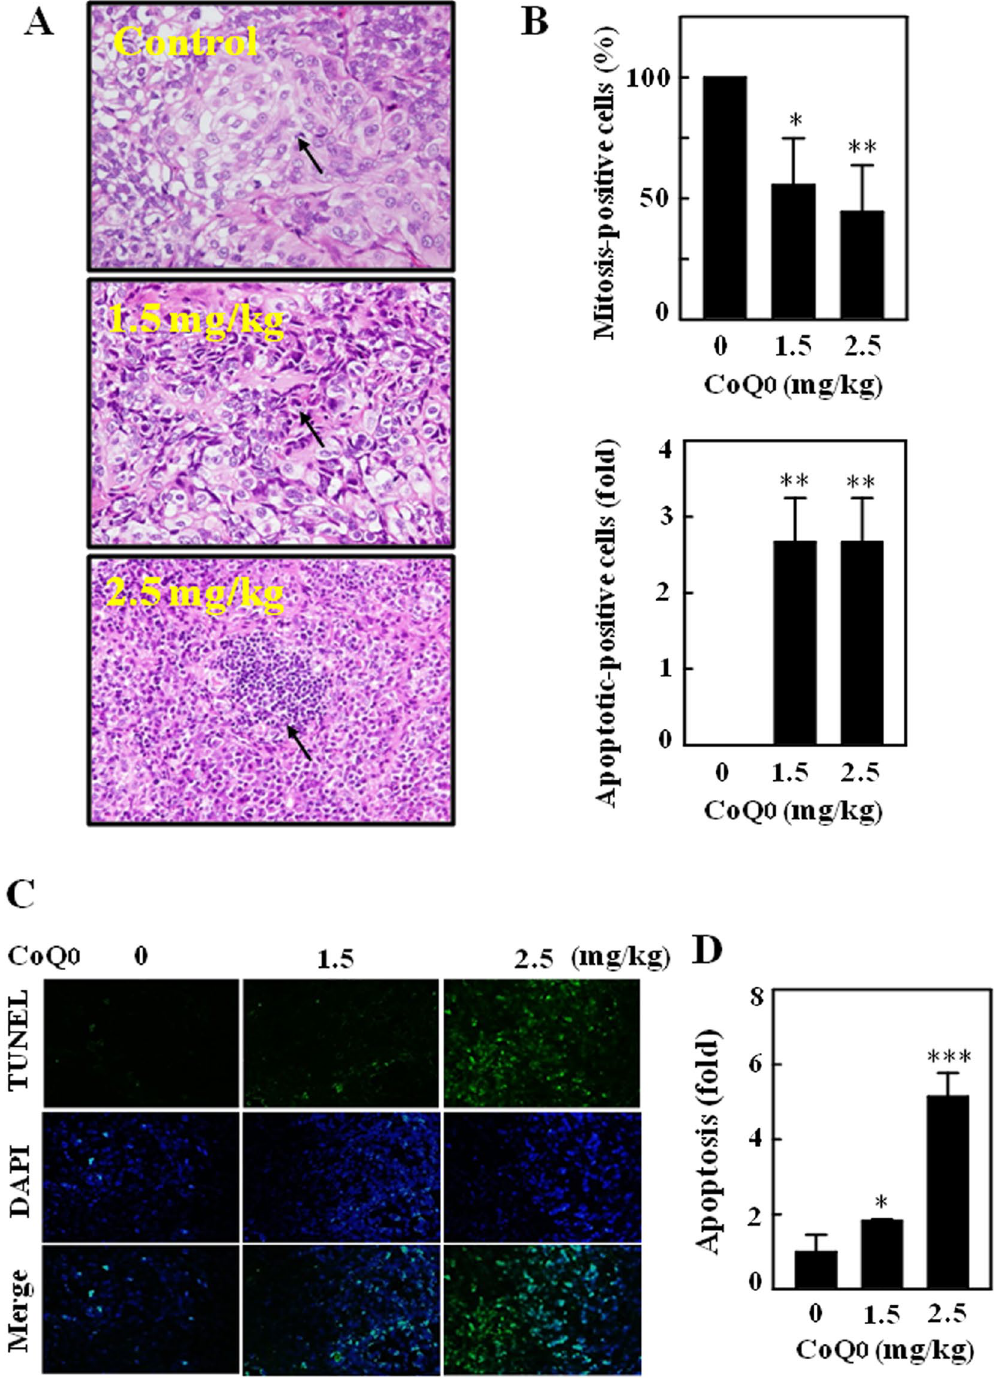
Figure 11. Histopathological analyses of mitosis and apoptosis in the tumors of SKOV-3 xenografted nude mice followed by CoQ 0 treatment. ( A,B ) Histopathological staining was performed to detect the mitotic- and apoptotic-cells in SKOV-3 xenografted tumors following CoQ 0 (1.5 and 2.5 mg/kg) treatment using light microscopy (20 × and 200 × magnification). Arrows indicate mitotic (tumor control) and pyknotic tumor cells (CoQ 0 ). The number of mitotic-positive and apoptotic-positive cells in microscopic fields of 3 samples was averaged, and presented as histogram. ( C,D ) In situ detection of apoptosis was performed using TUNEL staining in tumor sections from control and experimental analogues treated with CoQ 0 (1.5 and 2.5 mg/kg). The number of TUNEL-positive cells were quantified from 3 microscopic fields, and averaged. Results expressed as mean ± SD of three independent assays (n = 3). Significant at * p < 0.05; ** p < 0.01; *** p < 0.001 compared with vehicle treated